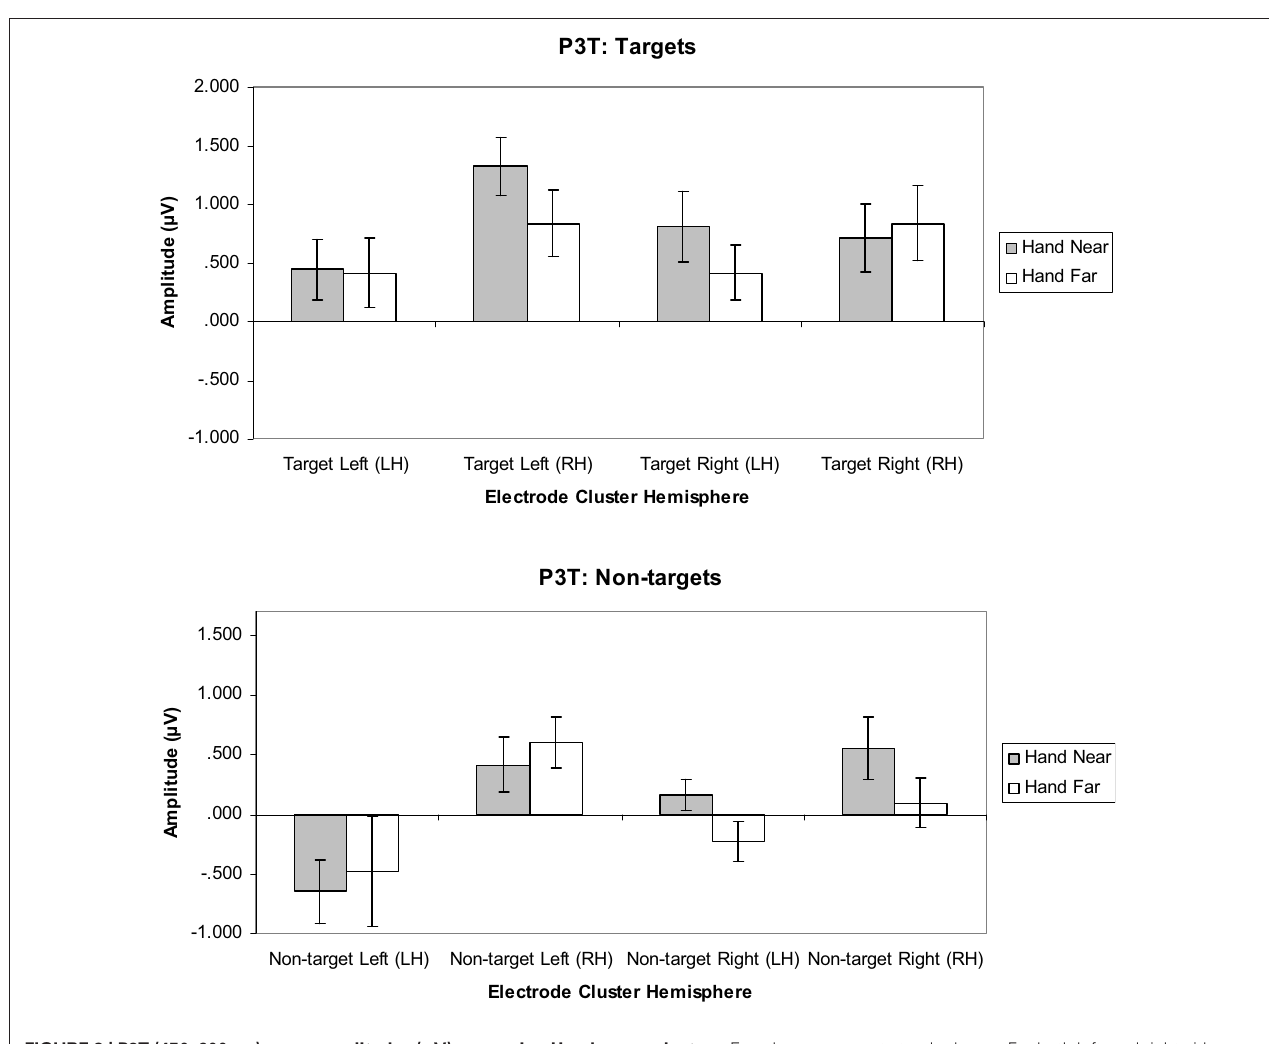
clusters. Error bars represent standard error. For both left- and right-side targets, Near condition P3T amplitudes continued to be larger relative to the Far condition in the contralateral